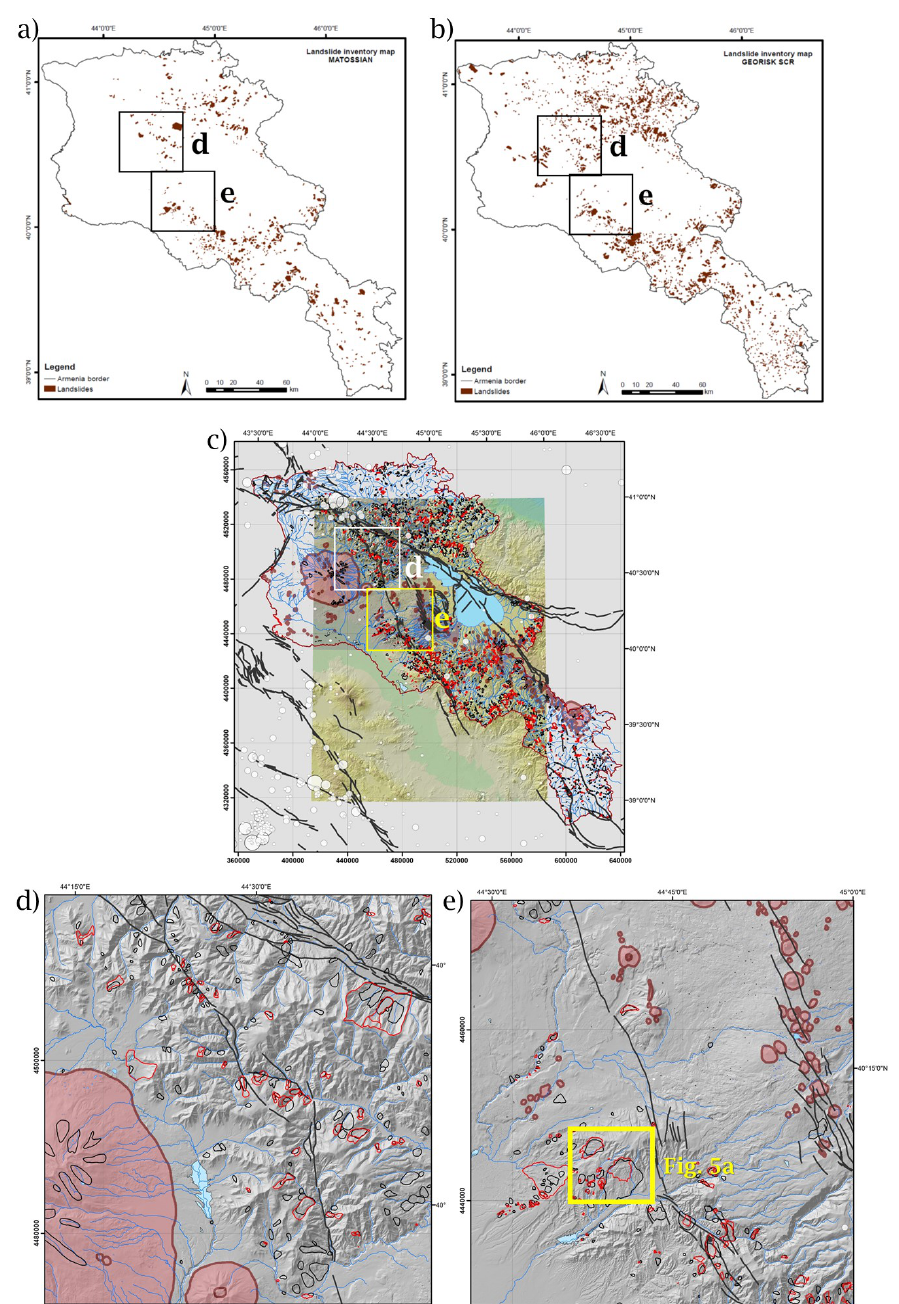
Figure 4. Maps of Armenia showing the distribution of landslides within the ( a ) Matossian, ( b ) Georisk, and ( c ) both catalogues (Matossian and Georisk catalogues in red and black polygons, respectively). Enlarged views show the regions ( d ) east-northeast of Aragats Volcano (pink shaded area) and ( e ) east of Yerevan, with landslides mapped from both the Matossian and Georisk catalogues in red and black, respectively. The DEM shown in ( c ) is the 28-m-resolution SRTM DEM, whereas the hillshade maps in ( d ) and ( e ) are derived from the 11-m-resolution TanDEM-X DEM. The yellow square in ( e ) outlines the area shown in Figure 5a.